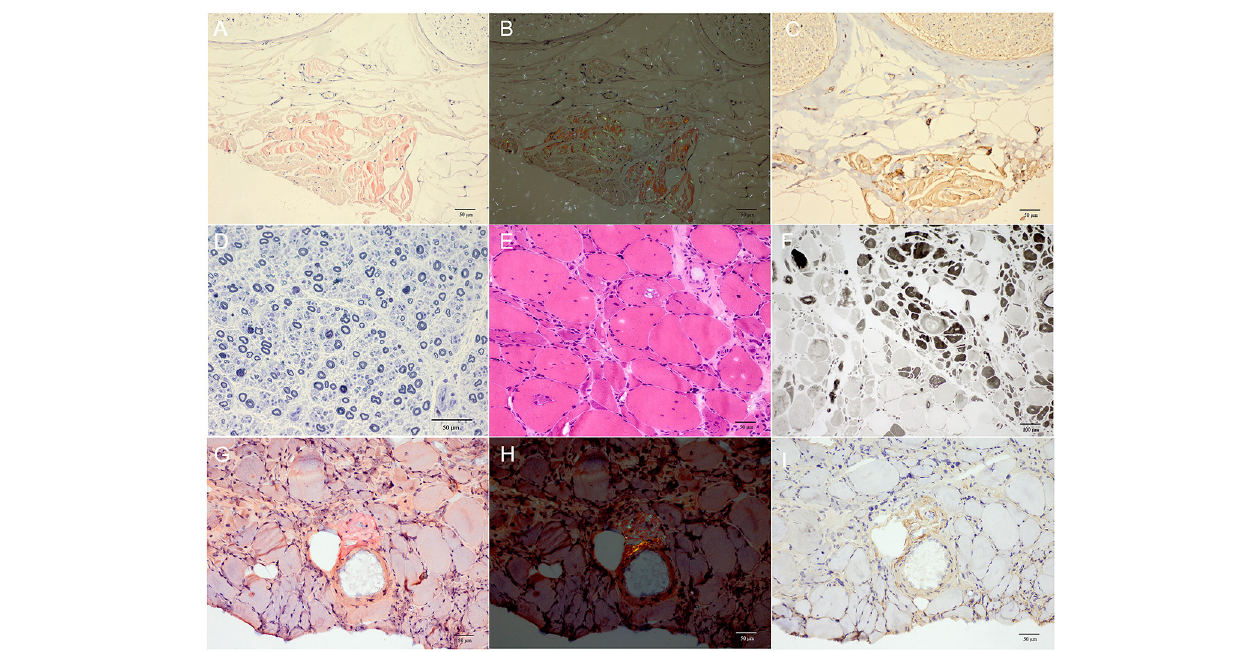
FIGURE 3 | (A–D) Sural nerve biopsy of patient II-4. (E–I) Gastrocnemius muscle biopsy of patient III-6. (A) Many red deposits were found in the epineurial interstitial tissues by Congo-red staining. (B) The “apple-green” deposits were observed under polarized light. (C) The existence of TTR-related amyloid deposits was further proved by TTR immunohistochemical staining. (D) The moderately reduced myelinated fiber density with 4,175.7/mm 2 of myelinated nerve fibers density and some axonal degeneration were observed with semithin section by toluidine blue staining. (E,F) Muscle biopsies showed both neurogenic changes (groups of small angular atrophic muscle fibers, involving two types) and myopathic changes (vacuoles muscle fibers) with H&E staining (E) and ATPase 4.6 staining (F) . (G,H) The Congo-red positive materials were also observed in the perivascular area with “apple-green” under polarized light and were positive by TTR immunohistochemical staining at the same site (I) . Scale bars = 50 µ m in (A–E,G–I) ; 100 µ m in (F)